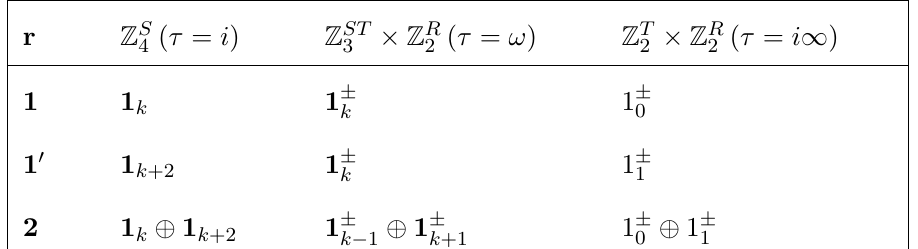
Table 6. Decompositions of ‘weighted’ ( r , k ) multiplets of Γ 0 groups. Irrep subscripts should be understood modulo n , where n = 4 , 3 in the first and second columns, respectively. Upper (lower) signs correspond to even (odd) values of k .